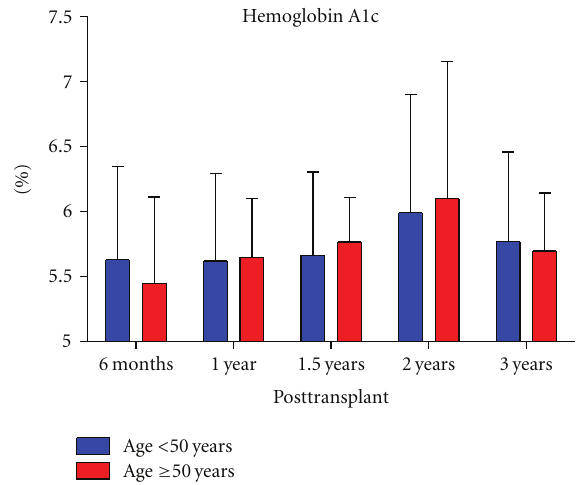
Figure 1: Pancreas allograft function. The bar graph illustrates the meanhemoglobinA1c (HgA1c) values for younger recipients (blue) and older recipients (red). The error bars represent the standard deviation. The Y -axis is the percent glycosylated hemoglobin present and the X -axis is the number of years posttransplant for each group. There was no significant di ff erence in HgA1c at 6 months, 1, 1.5, 2, and 3 years after transplant between the groups ( P > . 05).